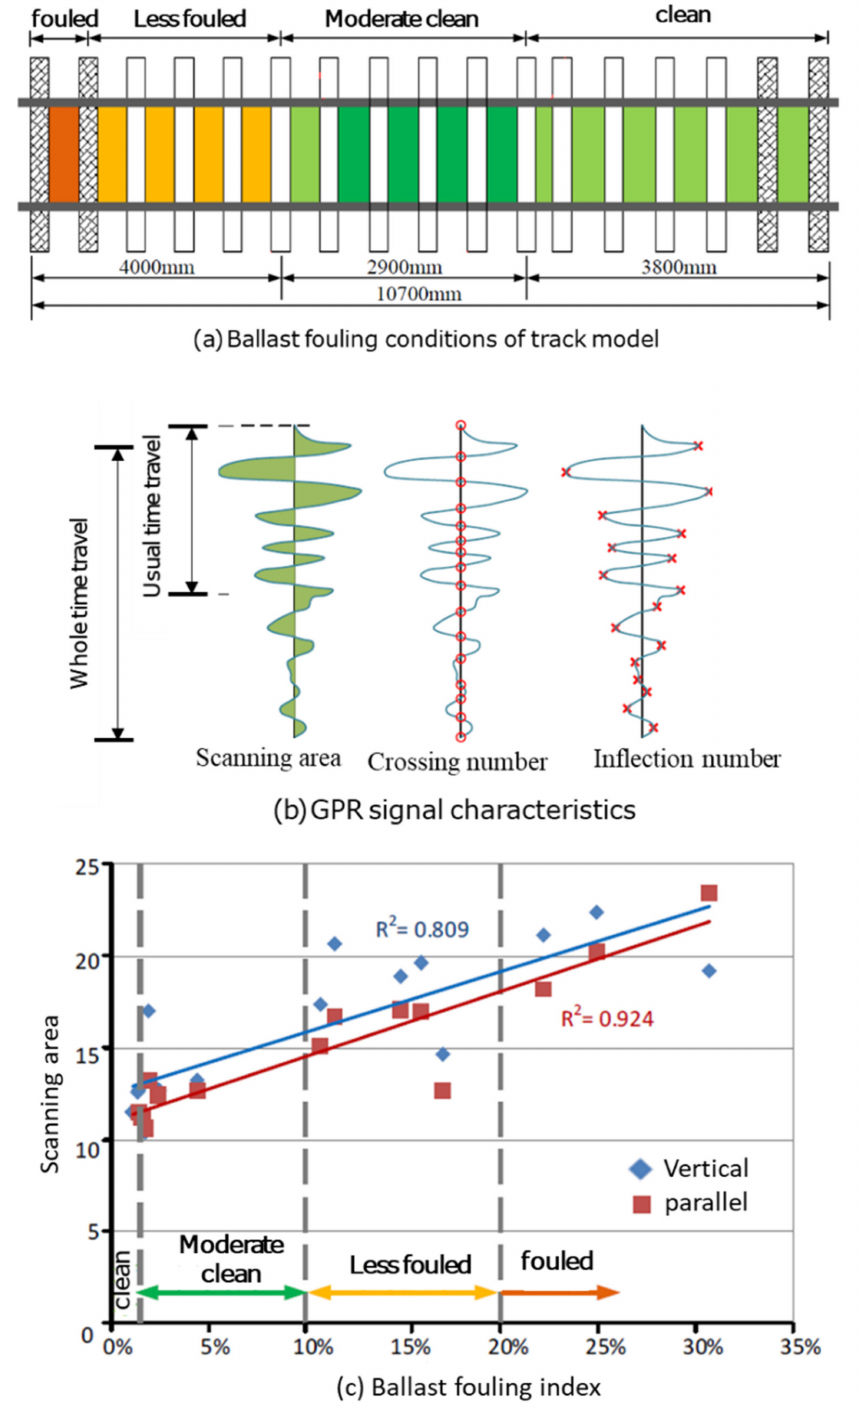
Figure 12. Full-scale ballast layer model and results from GPR (figure reproduced from